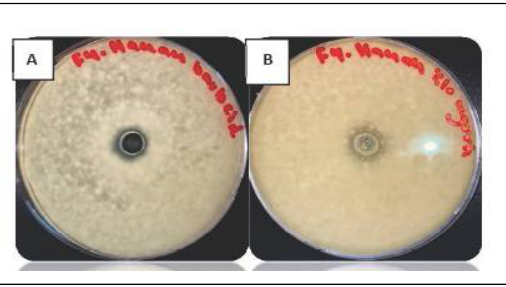
Figure 10: The antibacterial activity of (A) barbicide solution and (B) C. myrrh extract against Aspergillus